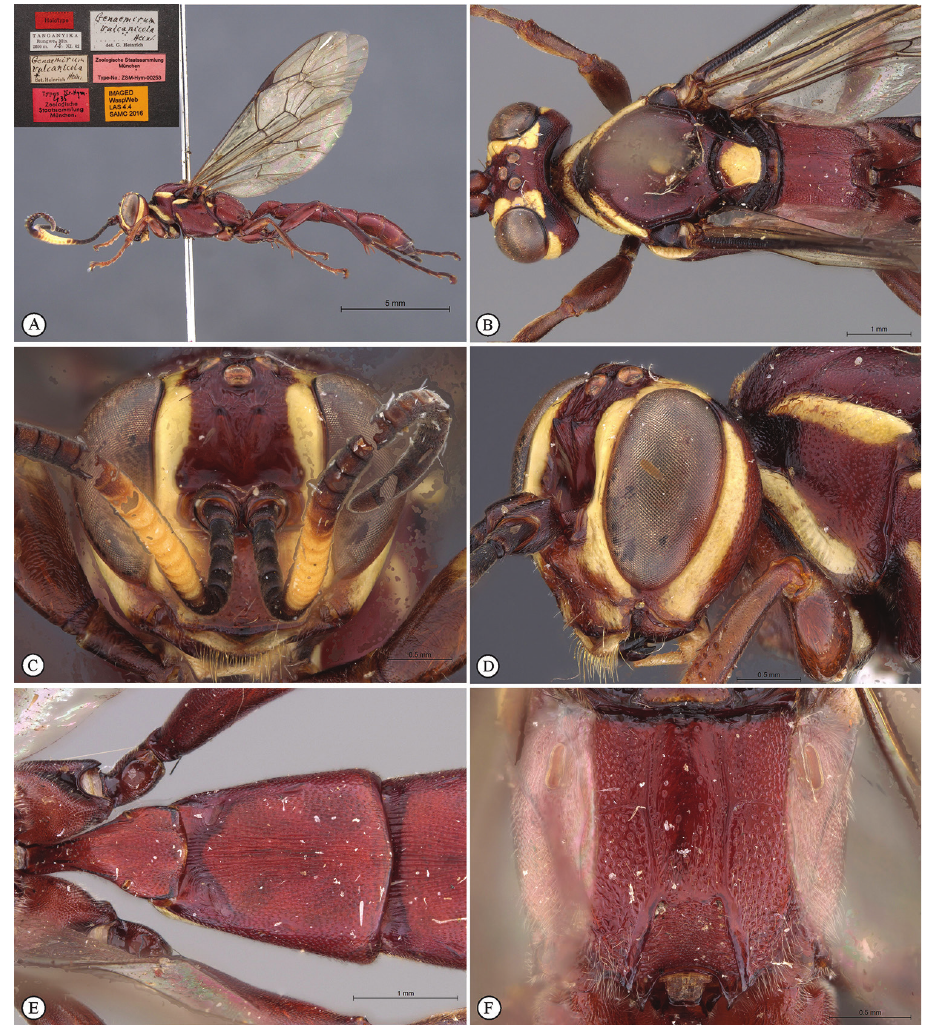
Figure 10. Genaemirum vulcanicola Heinrich. Holotype female. A habitus lateral view (inset: data labels) B head, mesosoma, dorsal view C head anterior view D head, mesosoma anterior-lateral view E metasomal tergites 1-4 dorsal view F propodeum, dorsal view.